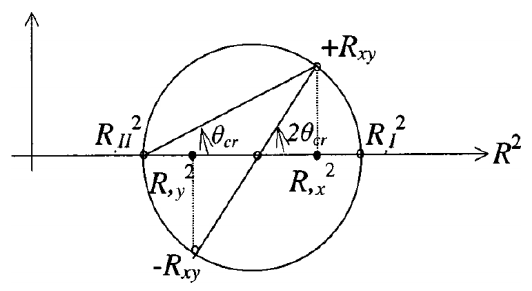
is shown in Figure 2.